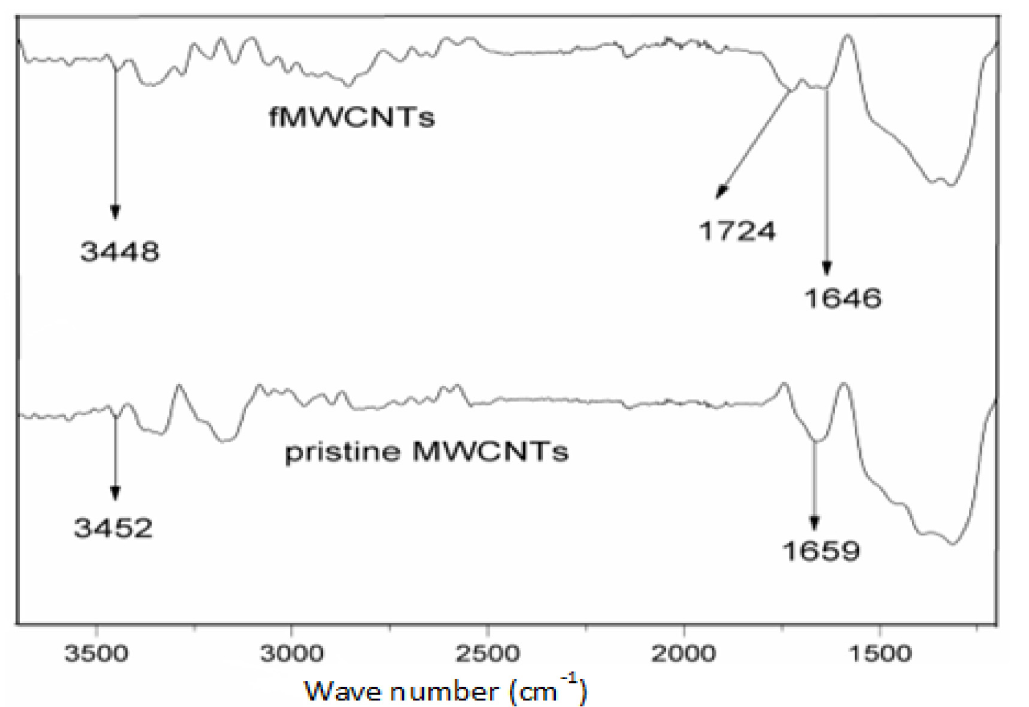
Fig 2. FTIR spectra of the pristine MWCNTs and functionalised